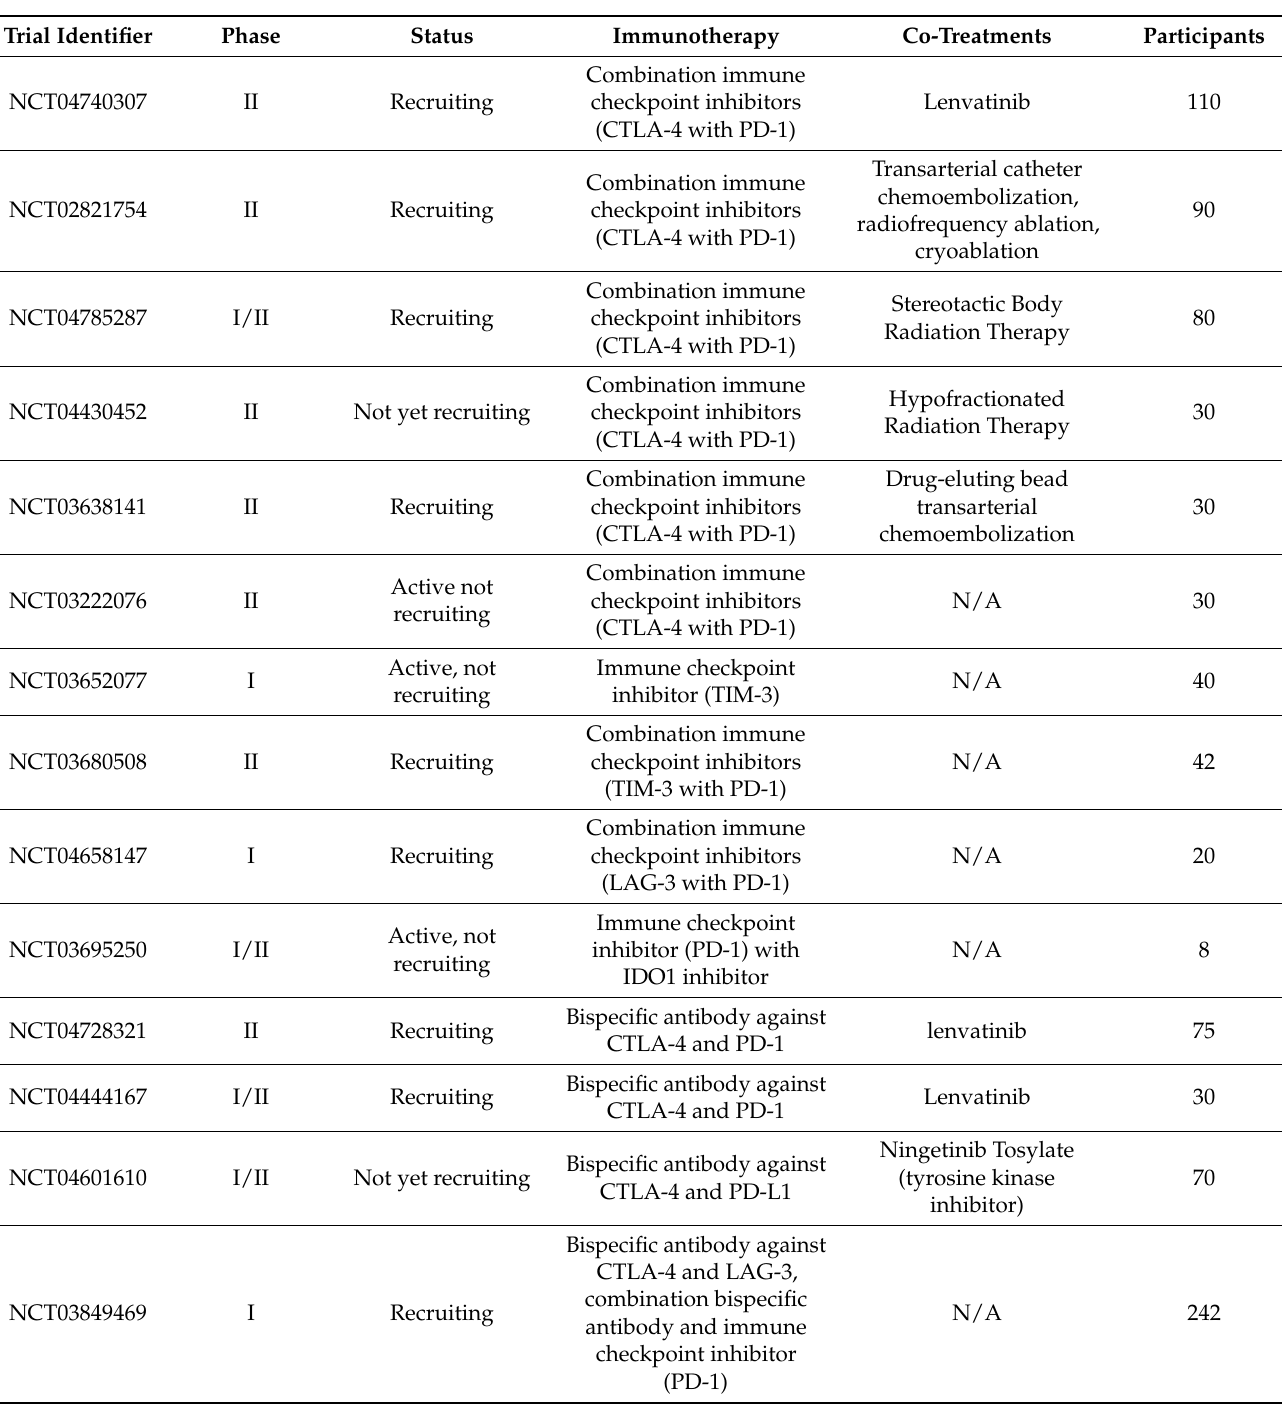
Table 1. Clinical trials currently evaluating immunotherapies in HCC. List of clinical trials involving combination immune checkpoint inhibitors, adoptive cell transfer, and other innovative immunotherapies in HCC. Source: clinicaltrials.gov (28 July 2021). HCC, hepatocellular carcinoma; TIL, tumor infiltrating lymphocyte; CAR-T cell, chimeric antigen receptor T